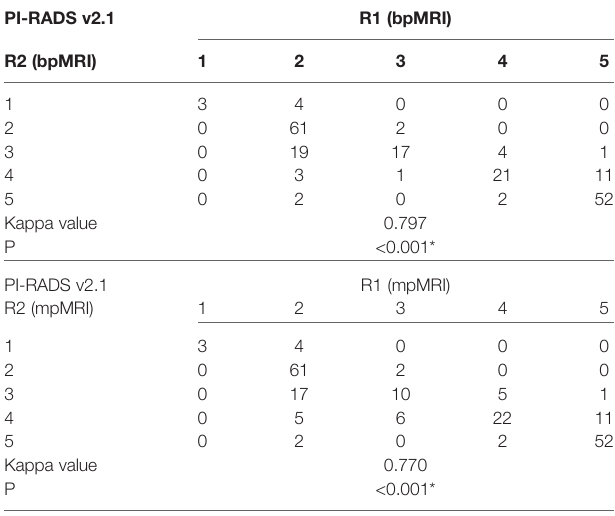
TABLE 3 | Assessment of Interrater agreement for PI-RADS v2.1 score with bpMRI and mpMRI. PI-RADS v2.1